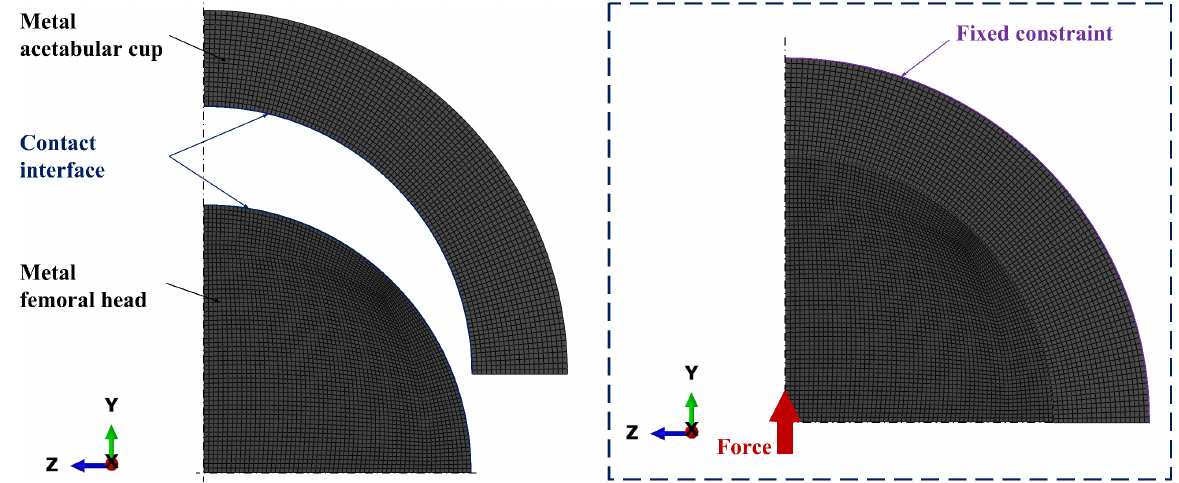
Figure 2. In silico model of metal-on-metal bearing couple.